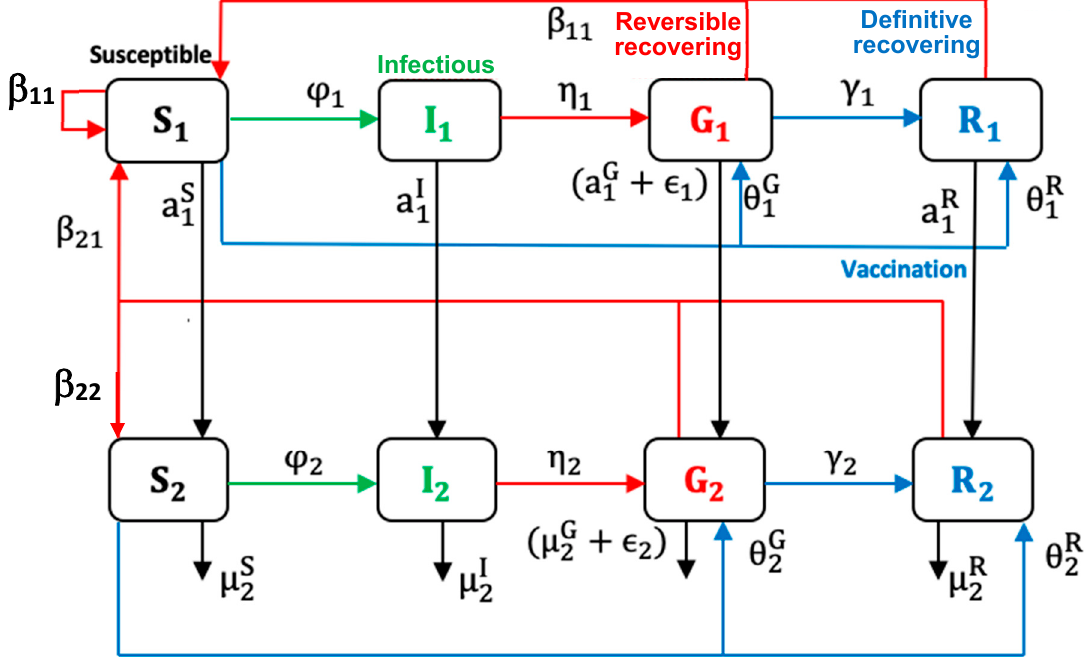
Figure 5. Age-dependent scheme for COVID-19 outbreak